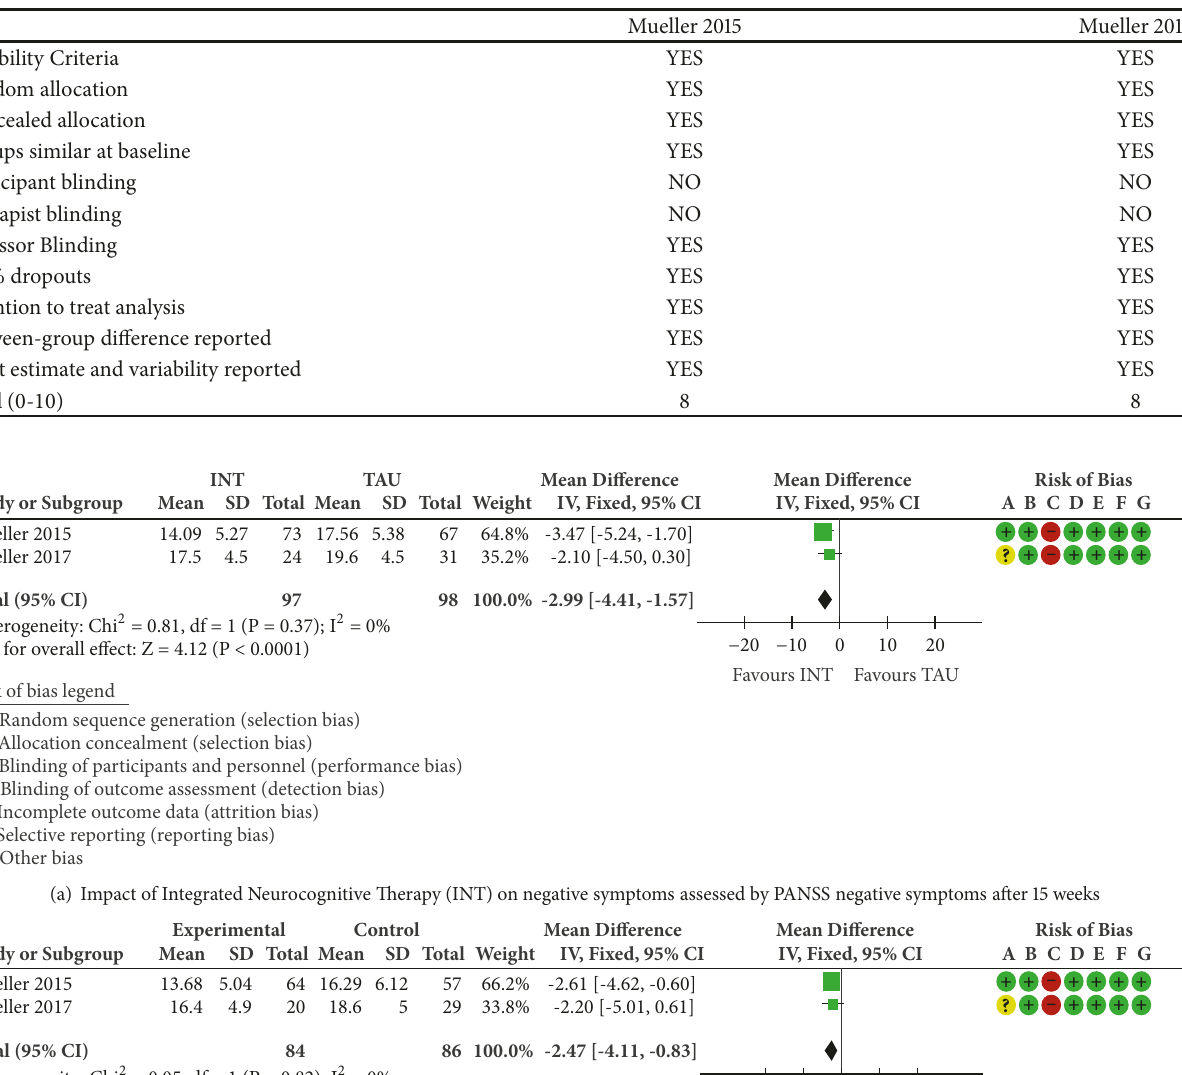
Table 2: Pedro scores for included papers (n=2) extracted from website www.pedro.org.au.